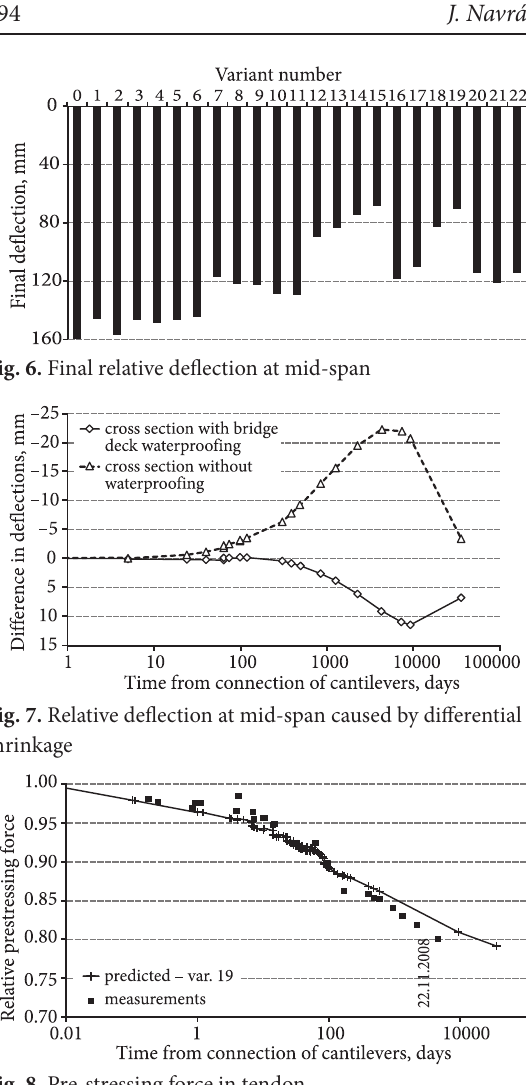
fig. 8. Pre-stressing force in